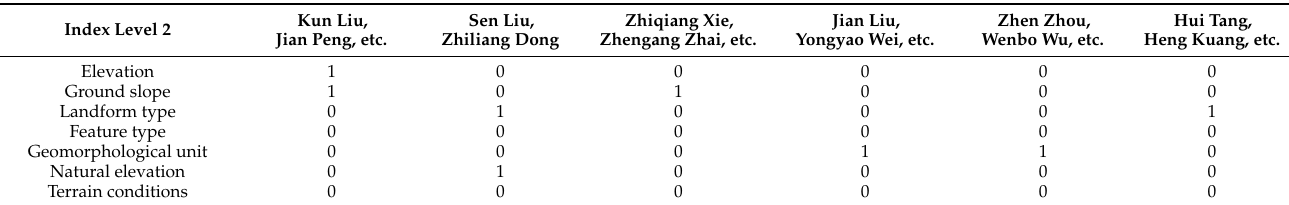
Table A6. Second level index binarization matrix.